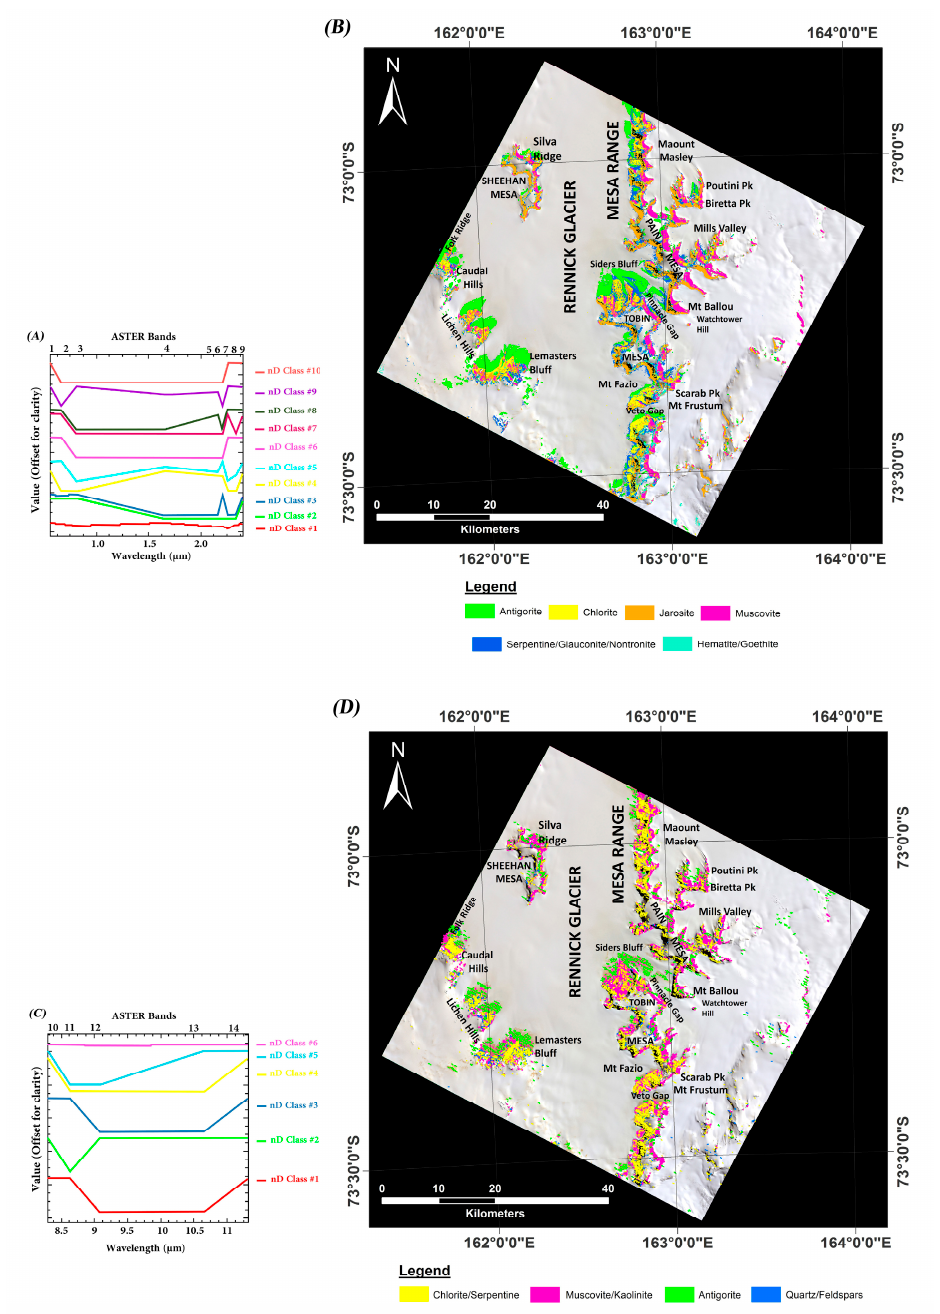
FIG 5 Figure 5. ( A ) Endmember spectra extracted from ASTER VINR+SWIR bands using the n-Dimensional analysis technique for the Mesa Range. ( B ) MTMF classification mineral maps derived from MF score images (VINR+SWIR bands) for the Mesa Range scene. ( C ) Endmember spectra extracted from ASTER TIR bands using the n-Dimensional analysis technique for the Mesa Range. ( D ) MTMF classification mineral maps derived from MF score images (TIR bands) for the Mesa Range scene. n-D class #4 shows strong Mg-OH absorption features about 2.35 µ m coincident with bands 7 and 8 of ASTER. Moreover, it shows strong Fe 3+ /Fe 2+ absorption features (0.48